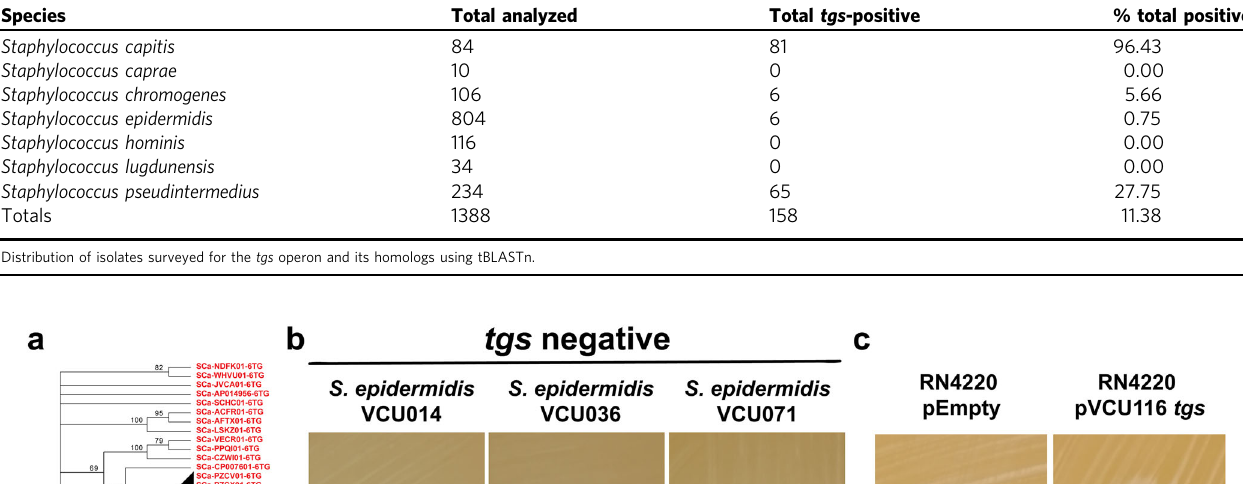
Table 2 The tgs operon among staphylococcal species. Species